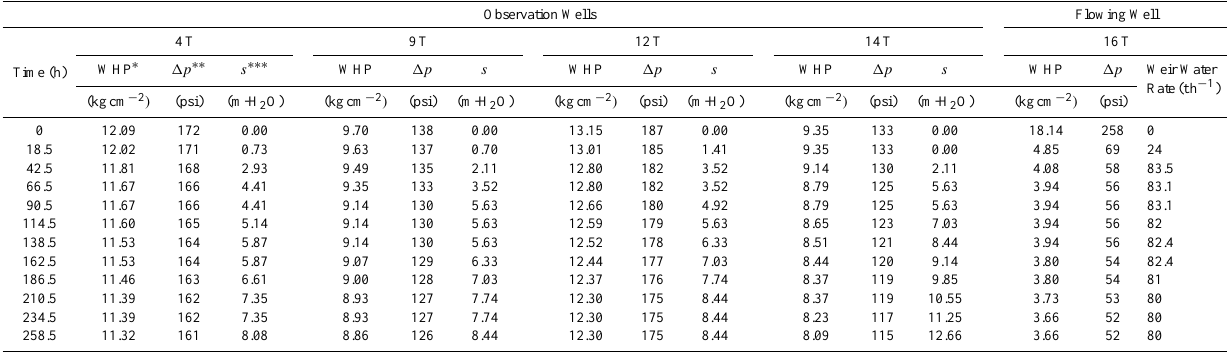
Table 1. Aquifer Test in CGF (Chang and Ramey 1979). Observation Wells Flowing